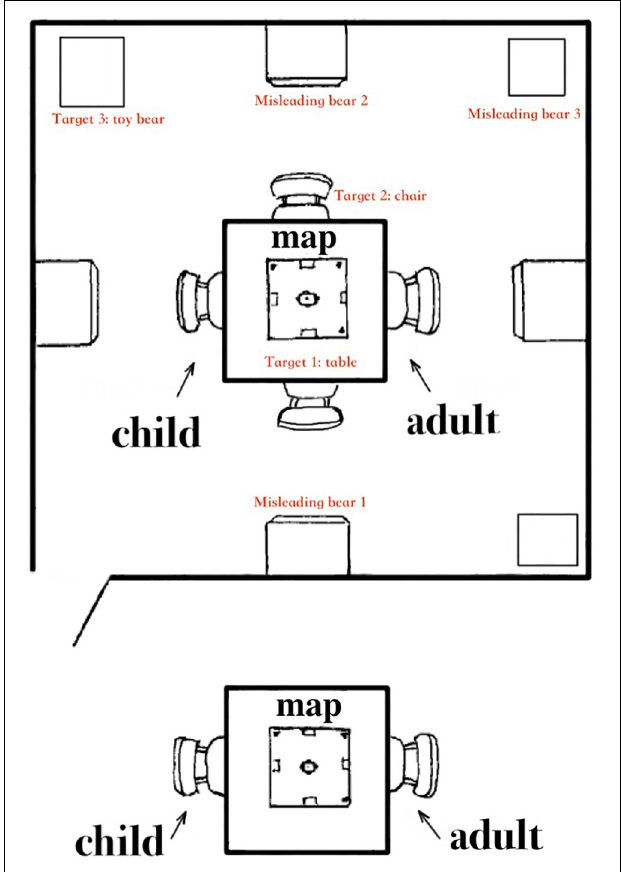
FIGURE 1 | The setting of the map-use